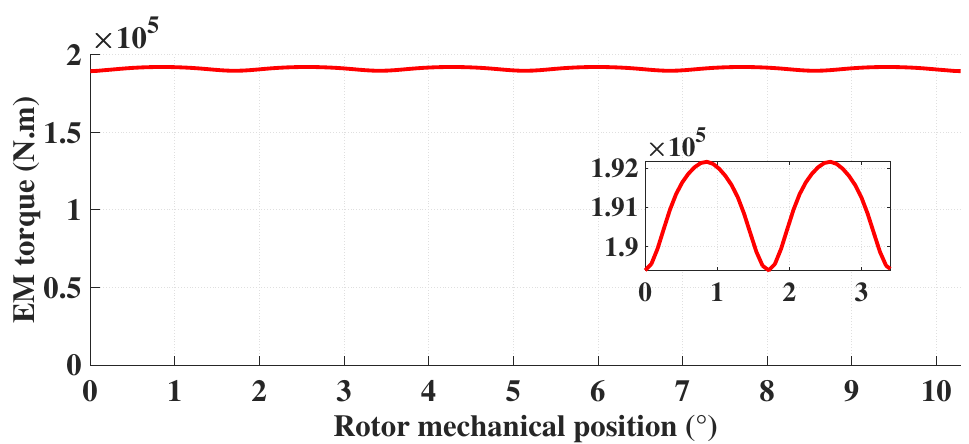
Figure 18. Electromagnetic torque.